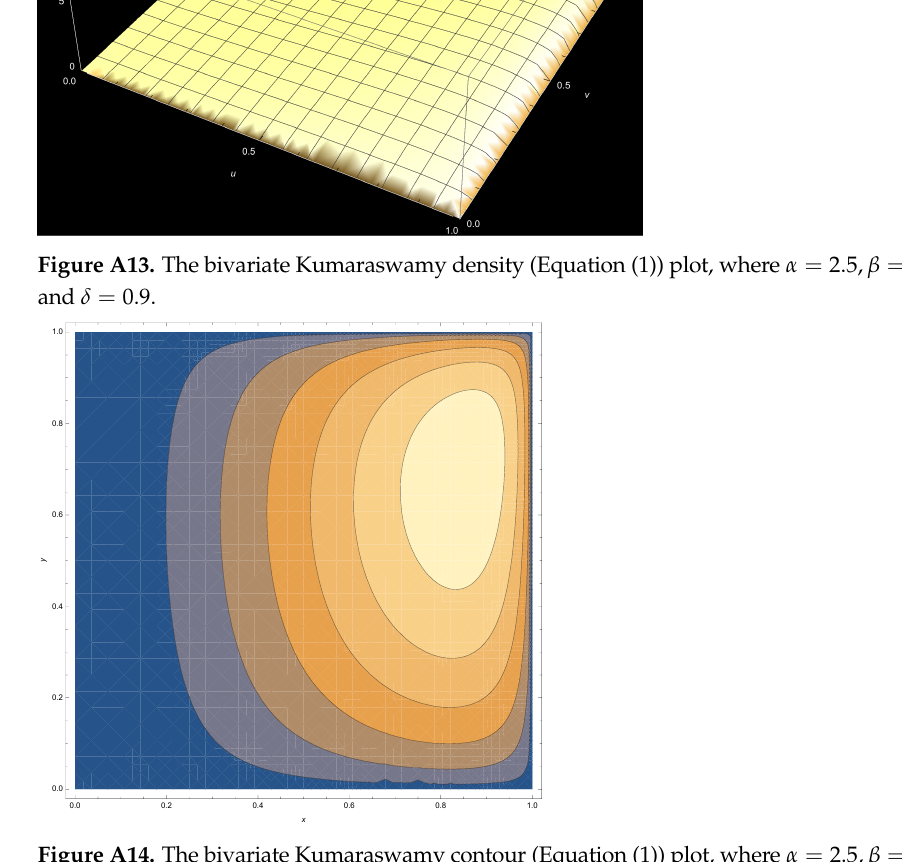
Figure A14. The bivariate Kumaraswamy contour (Equation (1)) plot, where α = 2.5, β = 1.5, θ = 0.5 and δ = 0.9.